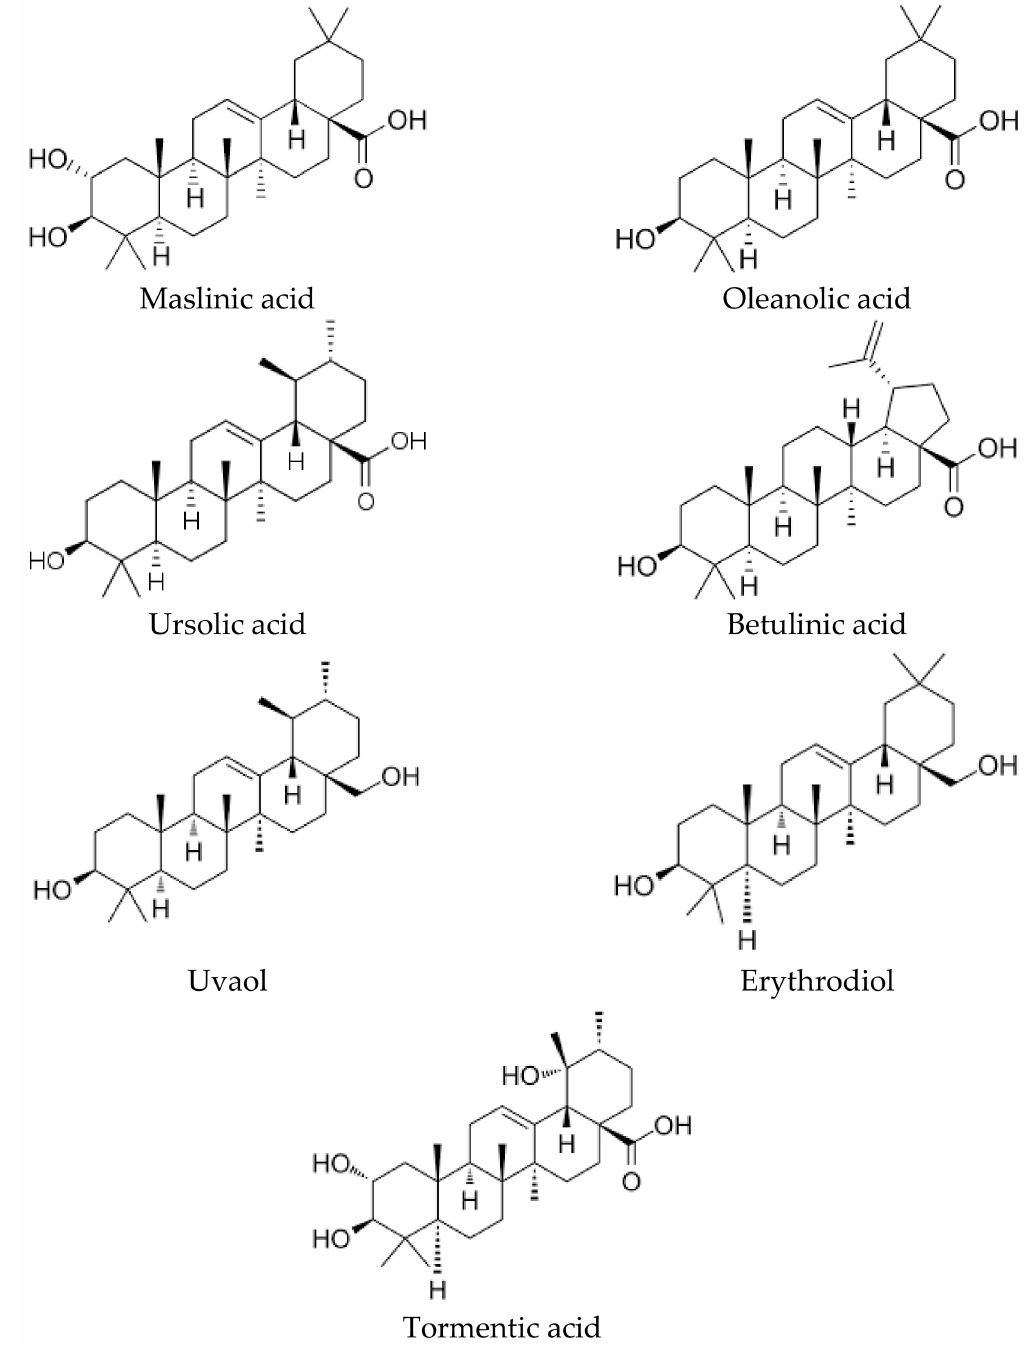
Figure 4. Chemical structure of the quantitatively most important triterpenoid compounds (acid and alcohols, maslinic, oleanolic, betulinic, ursolic, and tormentic acids and the triterpenic dialcohols, uvaol, and erythrodiol) present in the extracts of olive fruits and